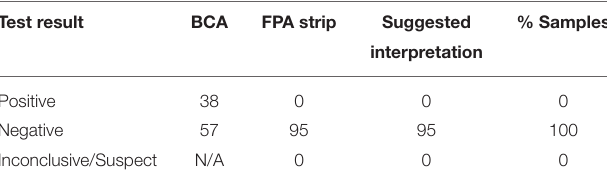
TABLE 2 | Test results and suggested interpretation of smooth strain Brucella tests for 95 prospective